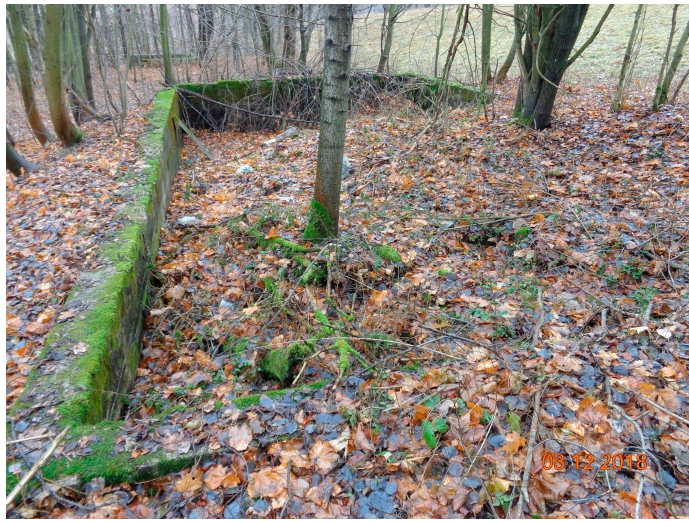
Figure 5. Remains of the camp’s water tank, AL Wolfsberg; photo P. Lewandowski.